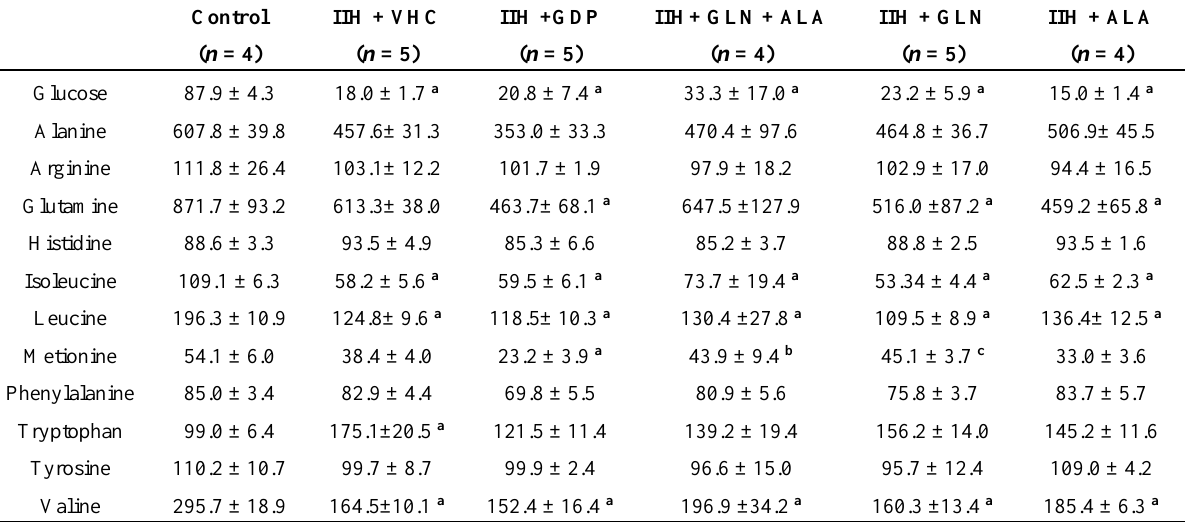
Table 3. Blood glucose (mg/dL) and amino acid (nmol/mL) levels 120 min after intraperitoneal insulin injection (IIH group). The IIH group was divided into 5 subgroups: IIH + oral vehicle (VHC), IIH + oral glutamine dipeptide (GDP), IIH + oral glutamine (GLN) + oral alanine (ALA), IIH + oral GLN or IIH + oral ALA. GDP (100 mg/kg), GLN (61.9 mg/kg) + ALA (38.1 mg/kg), GLN (61.9 mg/kg), or ALA (38.1 mg/kg) or VHC was orally administered. The Control group received intraperitoneal saline + oral VHC. Data expressed as means ± standard error were analyzed by ANOVA (Newman-Keuls post hoc test). a p < 0.05 vs. Control and b p < 0.05 vs . IIH + oral